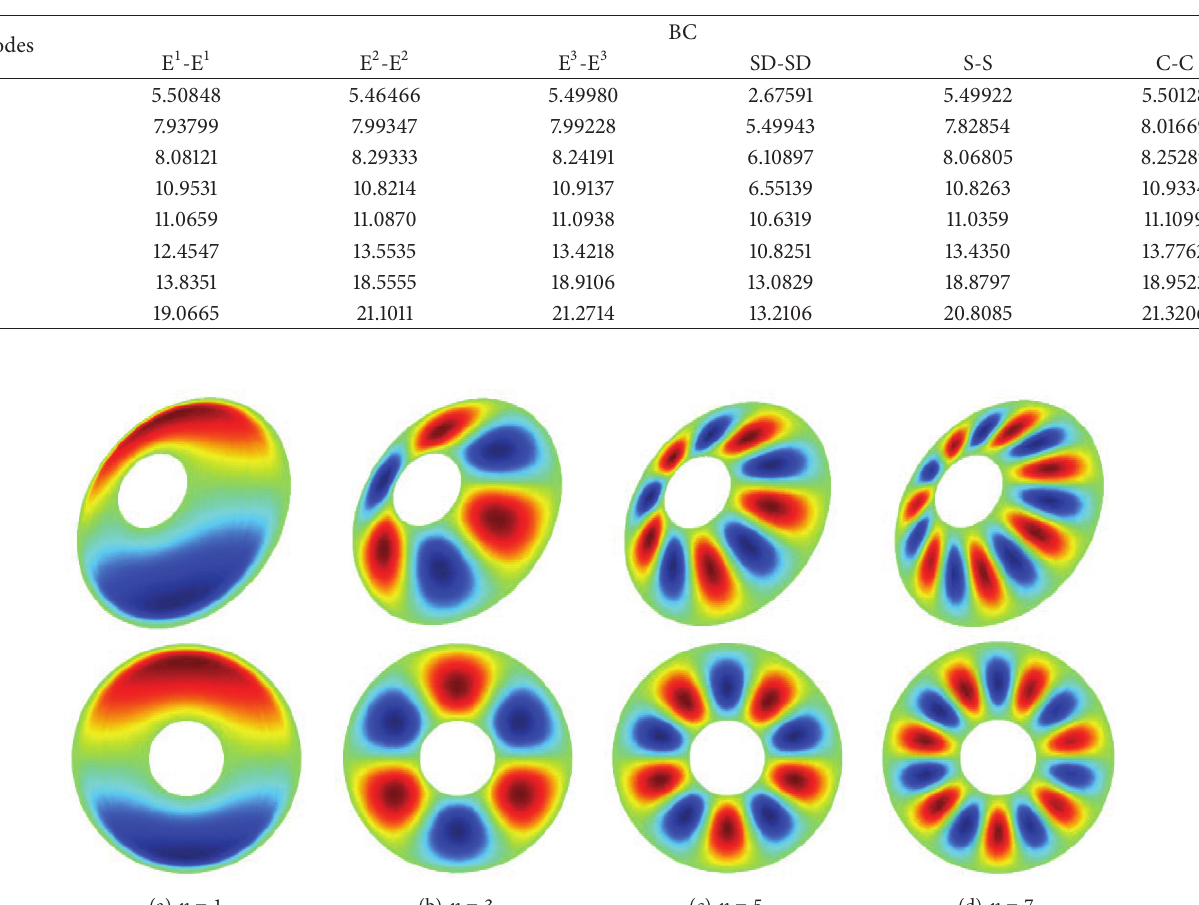
restraints. The material and geometrical parameters of the models in these two tables are employed as follows: 𝐸